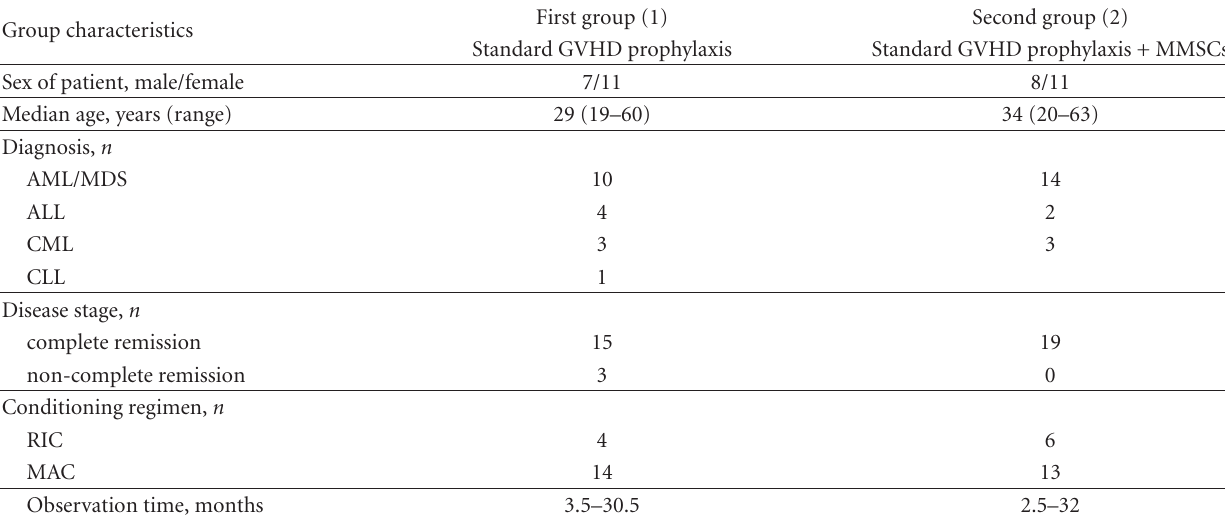
Table 1: Characteristics of the patients and treatments.